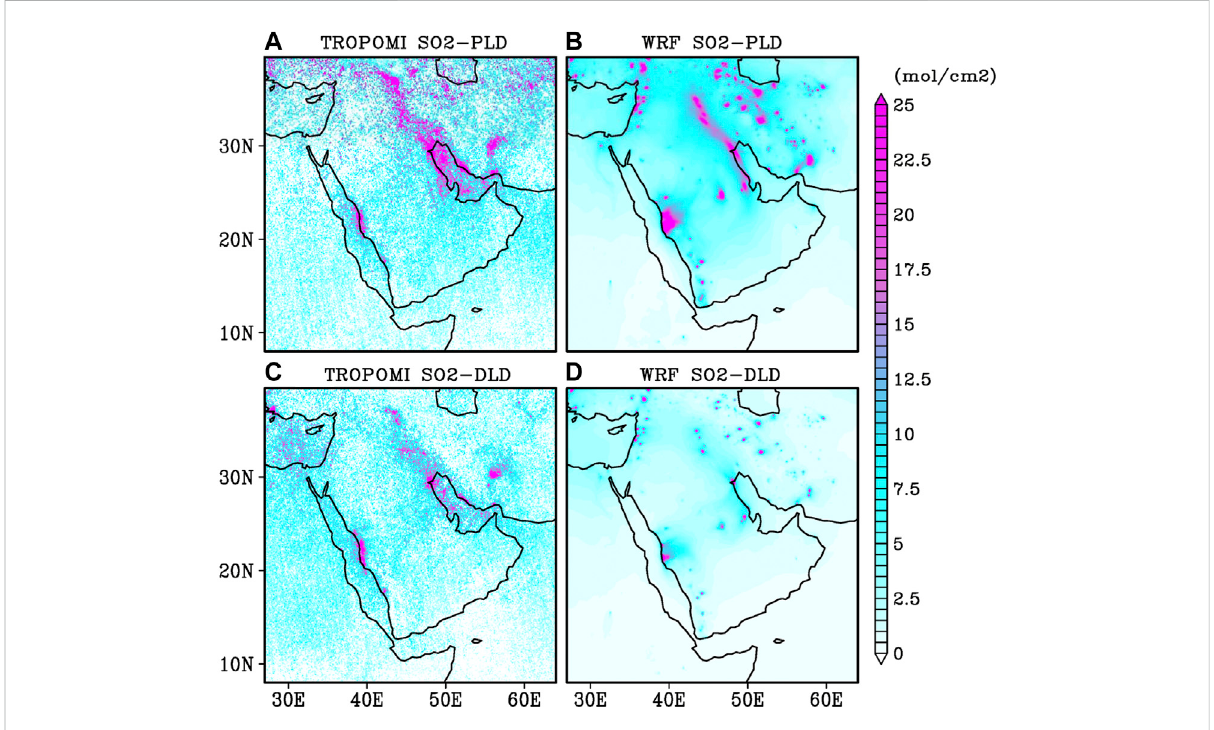
FIGURE 4 Time averaged spatial distribution of SO 2 as inferred from TROPOMI during (A) PLD and (C) DLD periods. (B, D) are the same as (A, C) but from WRF-Chem